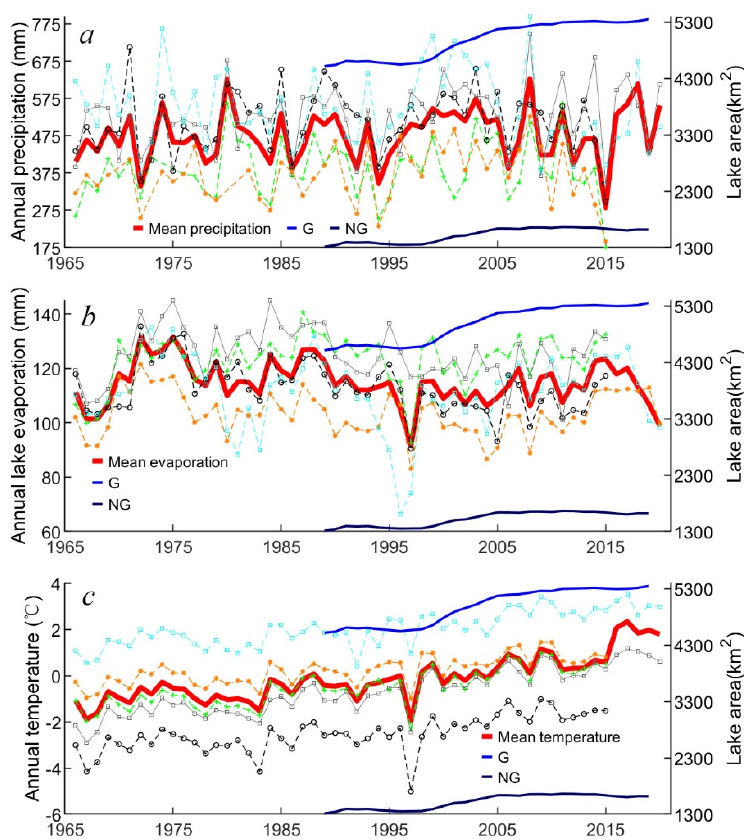
Figure 7. Annual precipitation ( a ), lake surface evaporation ( b ), and mean temperature ( c ) in 1966–2020, derived from five meteorological stations in the study area. The five thin and dashed lines of different colors in each chart represent variables of different stations, and the solid, red and thick line is the mean value of the five color curves. “G” and “NG” in the legends indicate the area of glacier-fed and non-glacier-fed lakes, respectively.